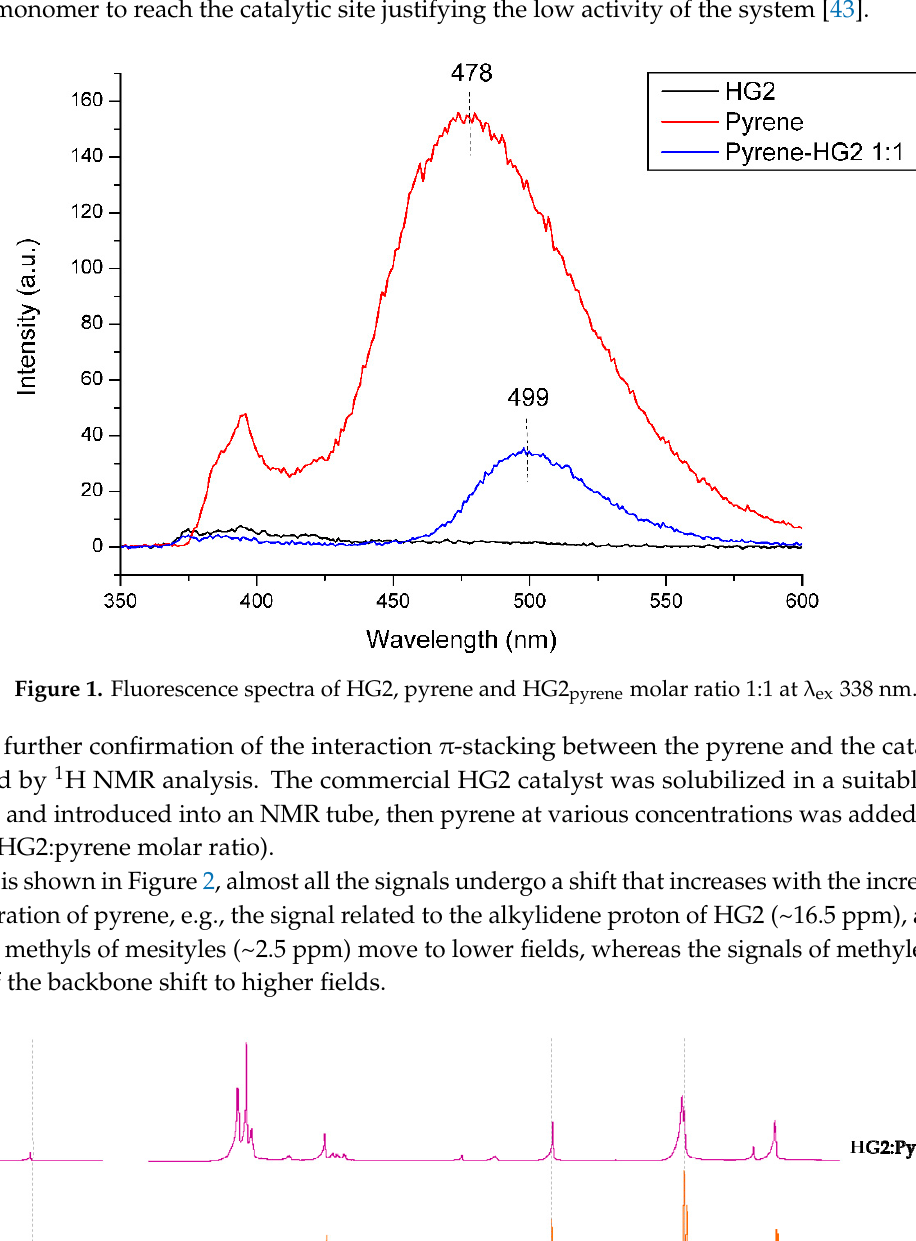
Figure 3. Synthesis of polymers having chain with a pyrene terminal. Polymerizations were carried out using a monomer/HG2 pyrene ratio of 100, in order to obtain short polymer chains, and to maximize the interaction with carbon-filler. The product obtained after polymerizing the 1,5-cyclooctadiene is a polybutadiene with a pyrene terminal. 1 H NMR analysis shows signals between 8.27 and 7.83, at 5.41 and at 2.03 ppm attributable to hydrogens of pyrene, protons of unsaturated carbons and protons of saturated carbons of the polymer chain, respectively. A fraction of this polymer was hydrogenated to give a pyrene-bonded polyethylene. The polymers reported in Figure 3 were dissolved in a suitable solvent, then the graphite was added in a 1:1 ratio in mass to allow the formation of the non-covalent interactions. It is interesting to note that, when the graphite is added to the solution, it remains well dispersed even in the absence of agitation. Instead, it tends to deposit on the bottom of the vial either when it is placed alone in the same solvent and when it is mixed with a polymer that does not have the terminal pyrene. In order to better understand what was observed, field emission scanning electron microscopy analysis was performed. Figure 4 shows the FESEM images of graphite (a), of a sample consisting of graphite and of polybutadiene with a terminal pyrene (b) and of a sample consisting of polybutadiene (without terminal pyrene) and graphite (c).